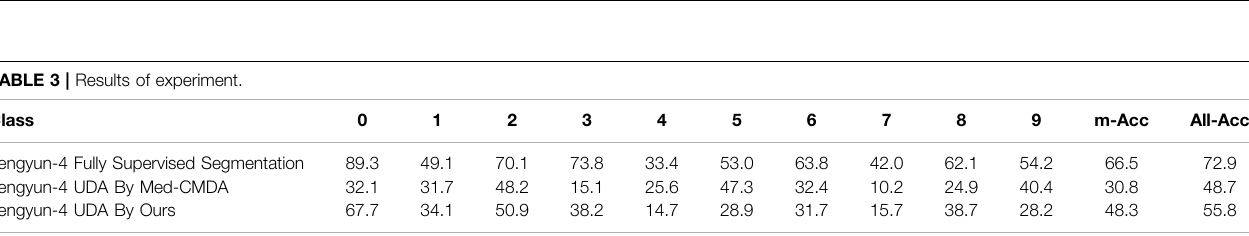
TABLE 3 | Results of